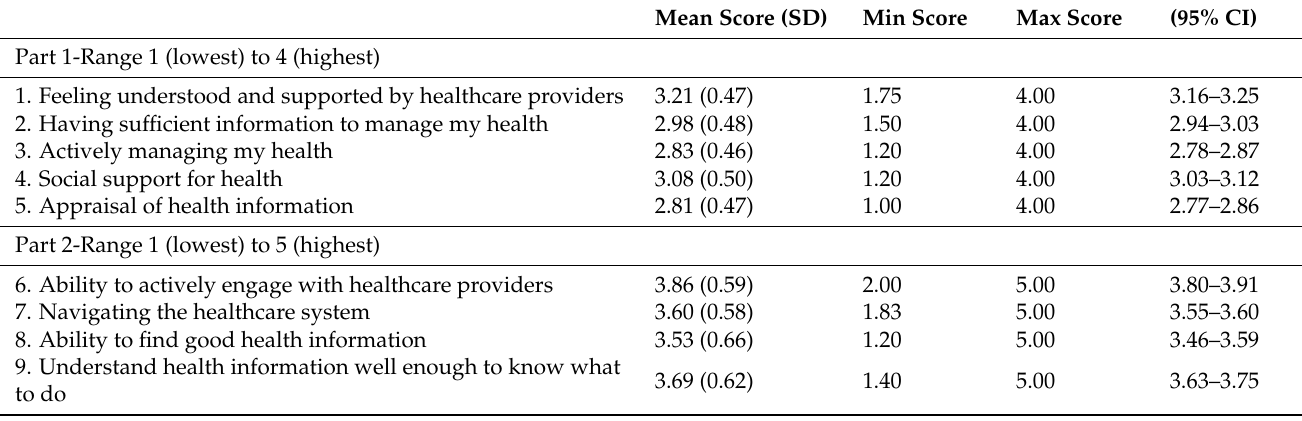
Table 6. Health Literacy Questionnaire (HLQ) scales